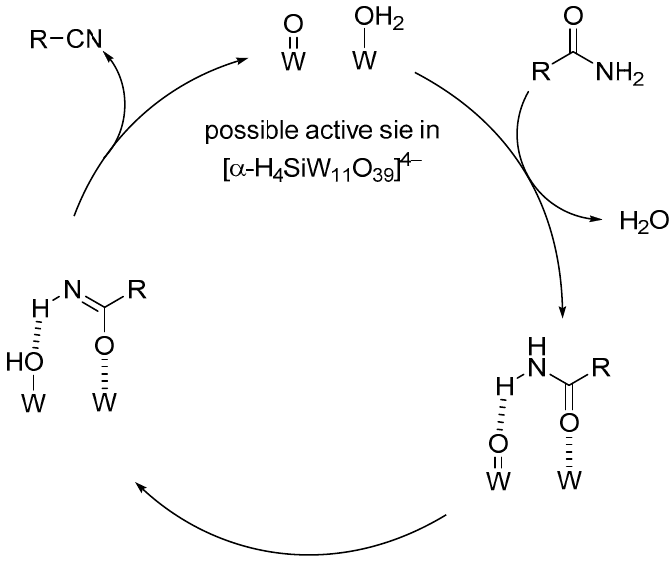
Figure 13. Proposed mechanism for the dehydration of amides to nitriles catalyzed by [ α -H 4 SiW 11 O 39 ] 4 − [123].